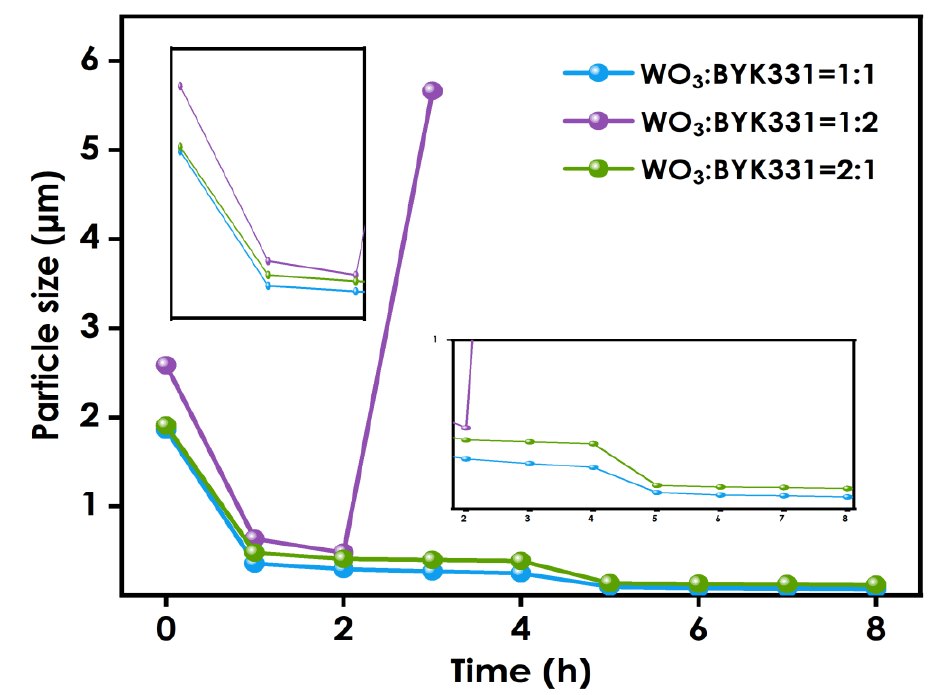
Figure 2. Particle size variation using different nano-WO 3 :dispersant ratios.